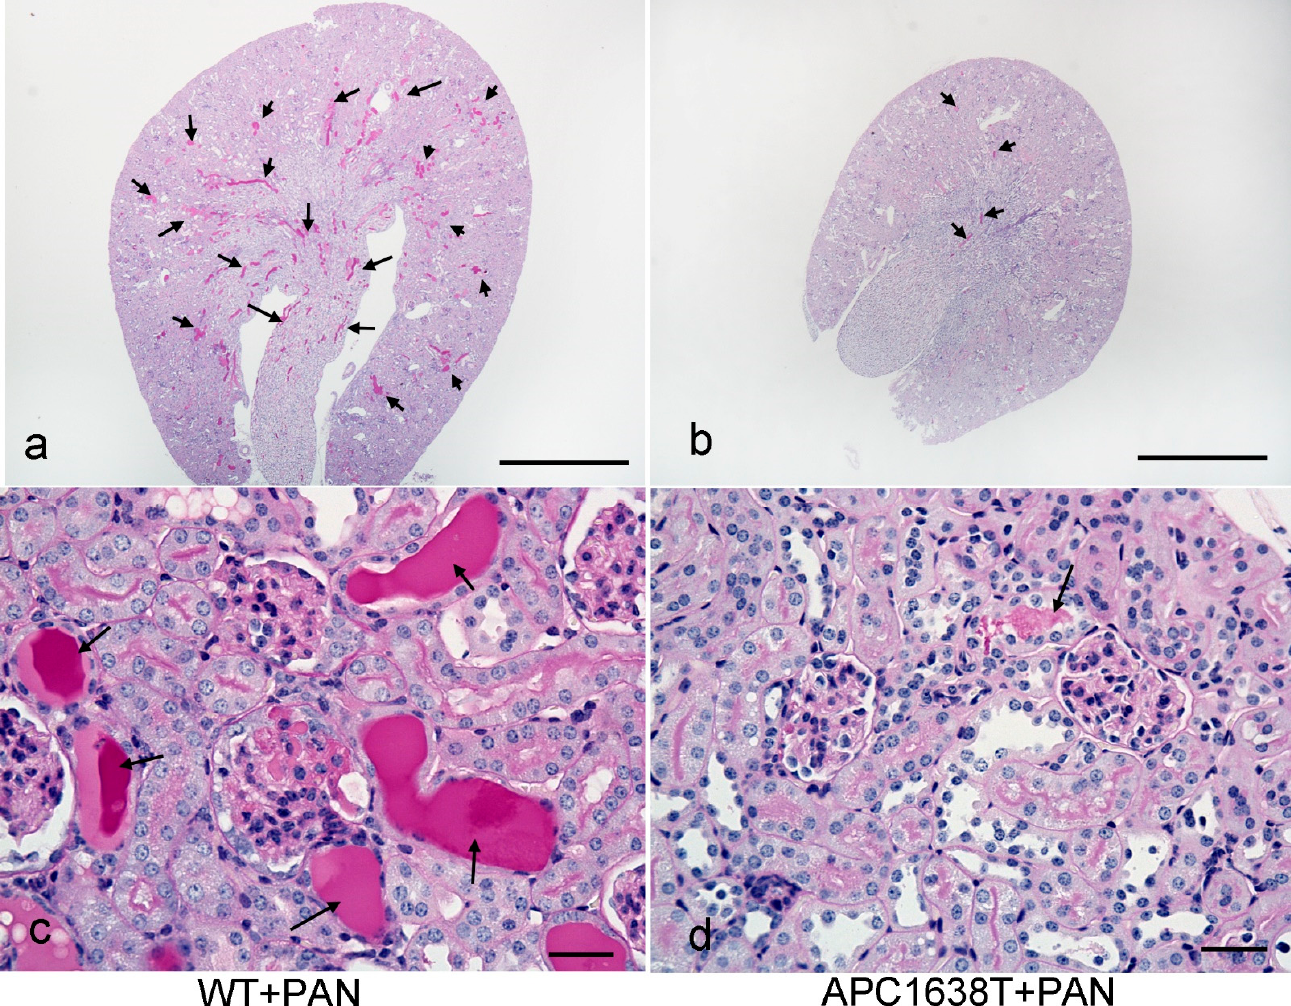
Figure 4. Periodic acid Schiff (PAS) staining of the kidney of wild-type+PAN nephrotic mouse ( a , c ) and APC1638T+PAN mouse ( b , d ). The bars indicate 500 μ m ( a , b ) and 50 μ m ( c , d ). The arrows indicate hyaline casts.